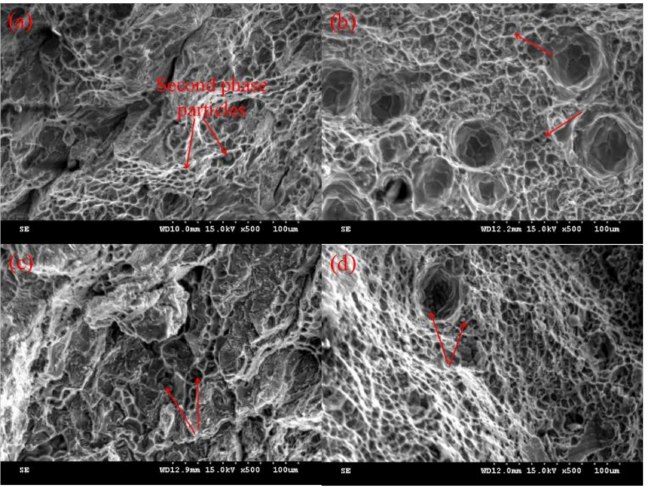
Figure 12. SEM fractograph morphology for tensile specimens of the WAAM 2219 alloys by different arc modes ( a ) CMT; ( b ) CMT-ADV; ( c ) CMT-P, and ( d )